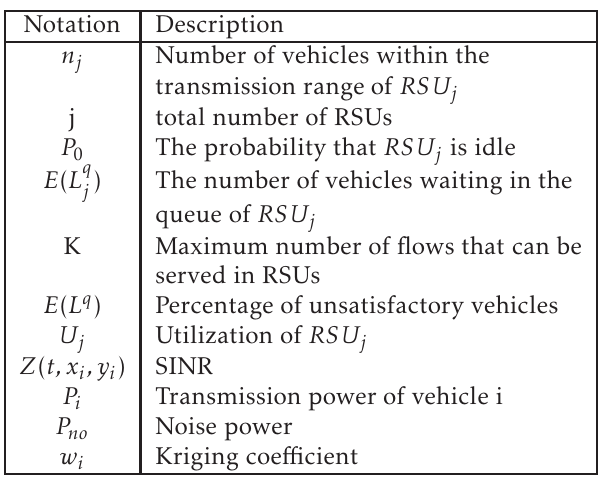
Table 1. Mathematical